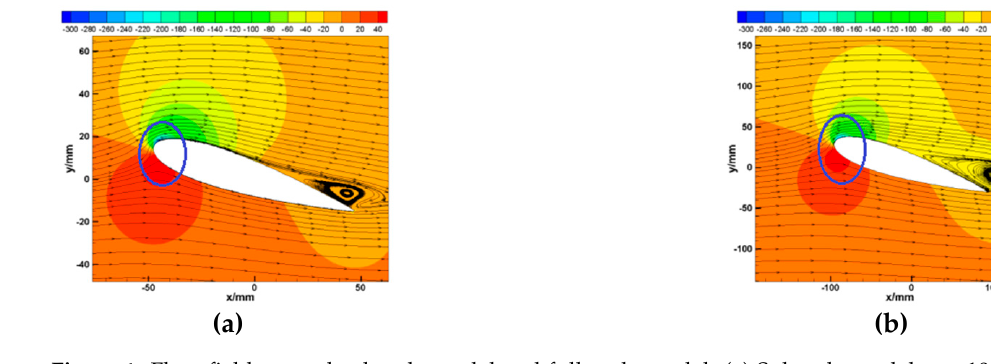
Figure 1. Flow field around subscale model and full-scale model: ( a ) Subscale model: c = 100 mm; ( b ) Full-scale model: c = 200 mm.